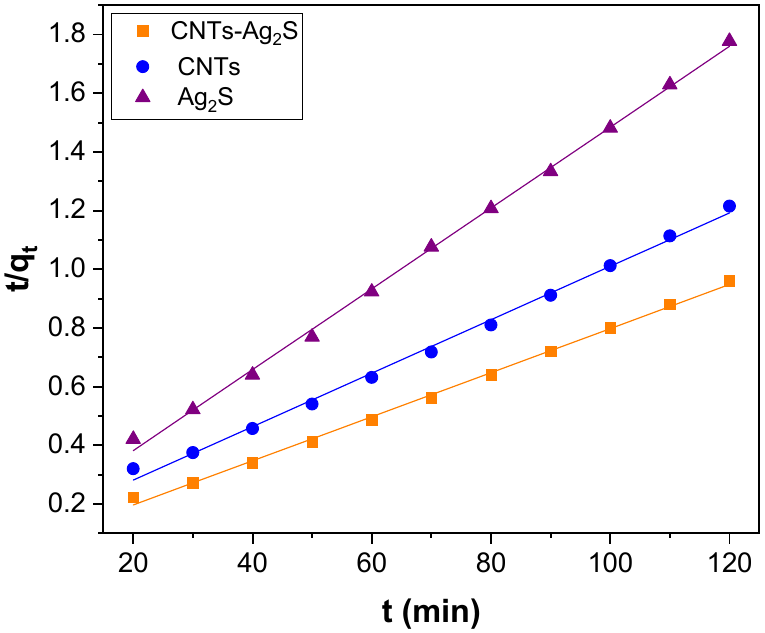
Figure 9. Pseudo-second-order kinetics for Cd(II) adsorption over CNTs, Ag 2 S, and CNTs-Ag 2 Figure 9. Pseudo ‐ second ‐ order kinetics for Cd(II) adsorption over CNTs, Ag 2 S, and CNTs ‐ Ag 2 S.